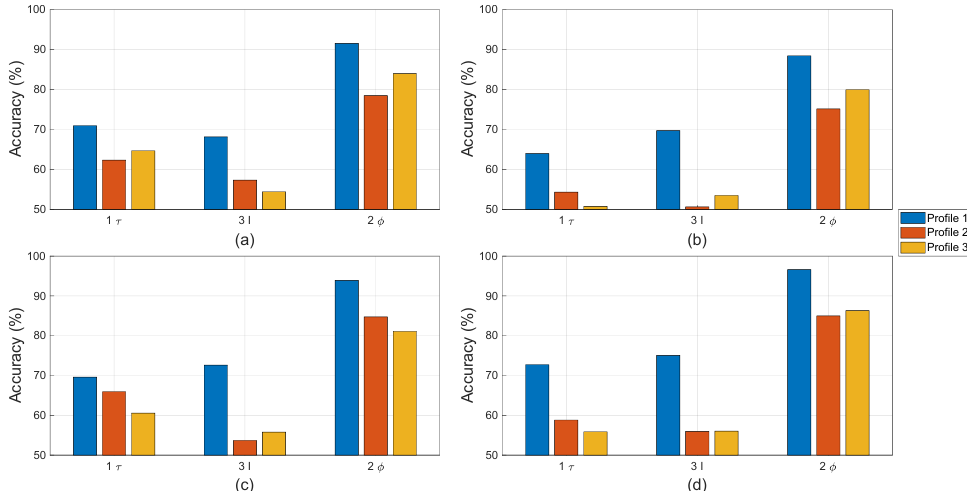
Figure 12. Detection accuracy with ITSC alone obtained by ( a ) EDT, ( b ) KNN, ( c ) SVM, and ( d ) FNN.